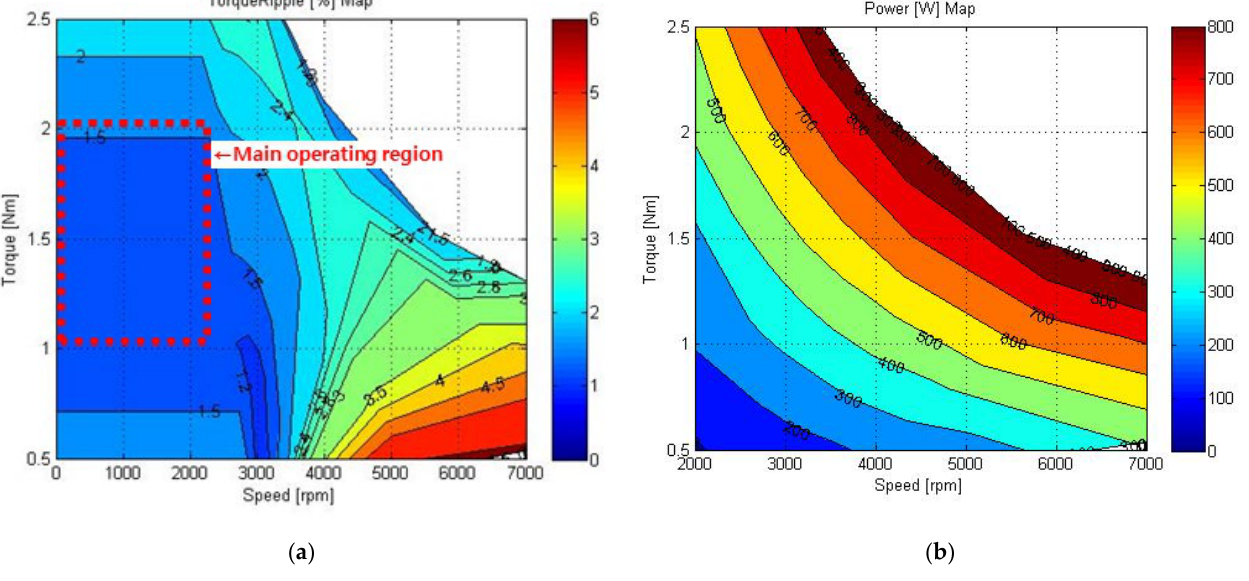
Figure 15. Motor characteristics maps of the optimized model: ( a ) torque ripple map; ( b ) power map.